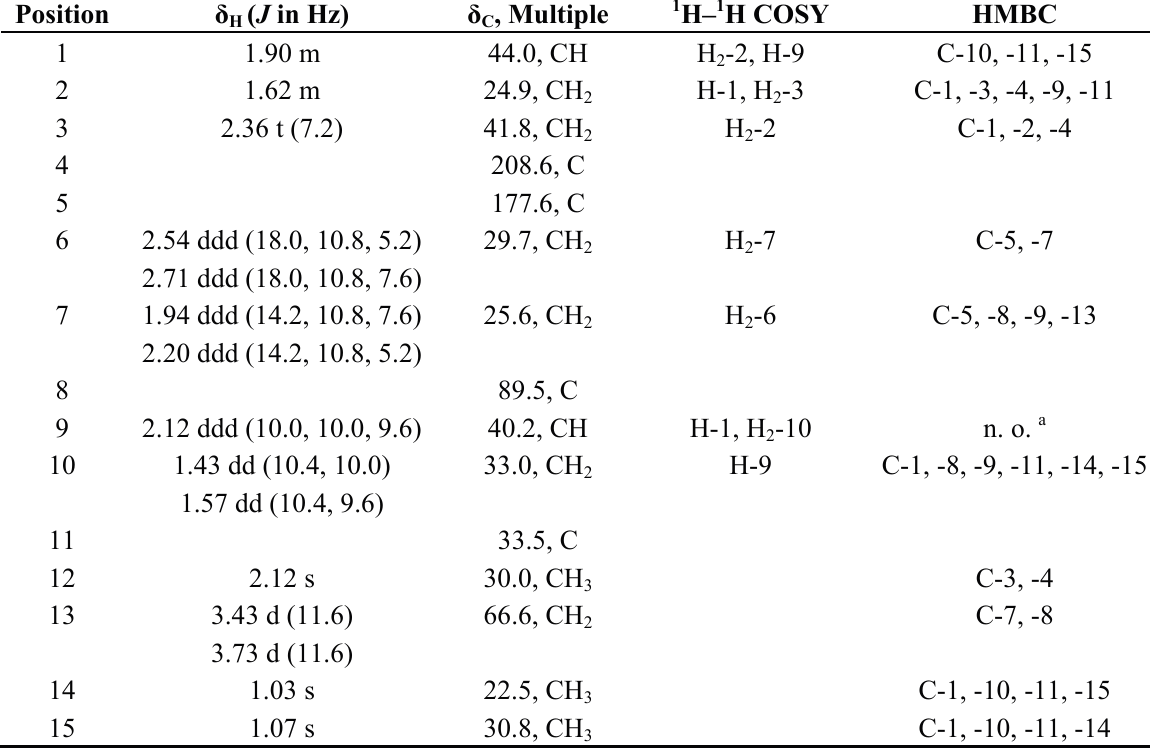
Table 2. 1 H (400 MHz, CDCl HMBC correlations for rumphellaone C ( 2